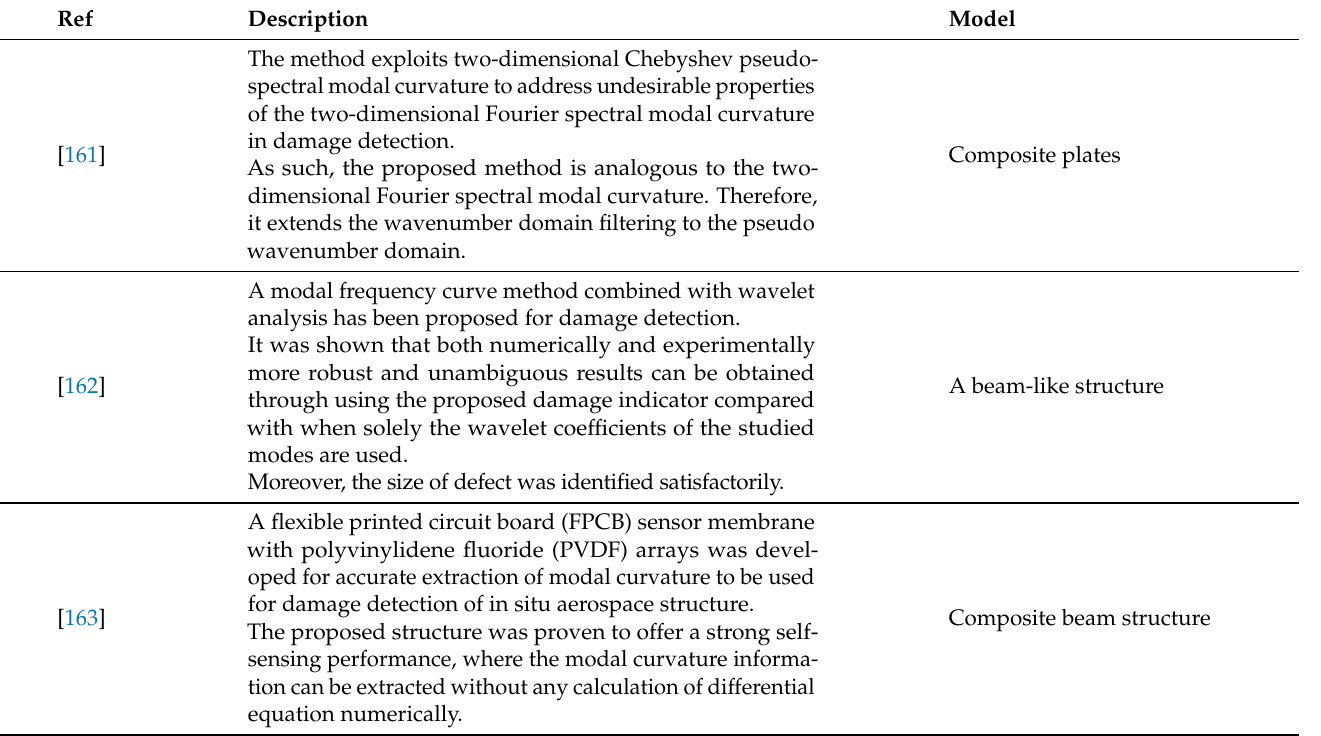
Table 11. Some recent developments in the application of MCM in damage detection of composite